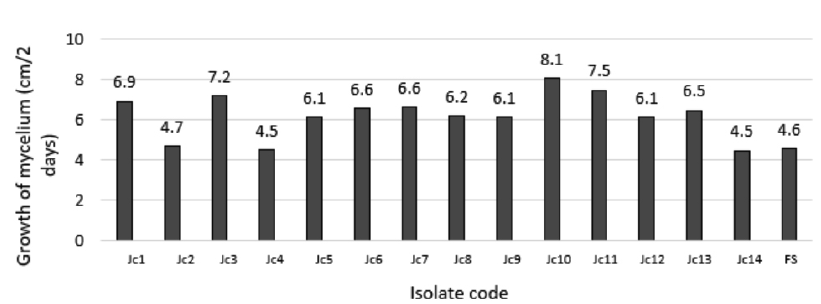
Fig. 2. Mycelium growth of Jatropha leaves Endophytes isolates ( J. curcas L.) and F. oxysporum